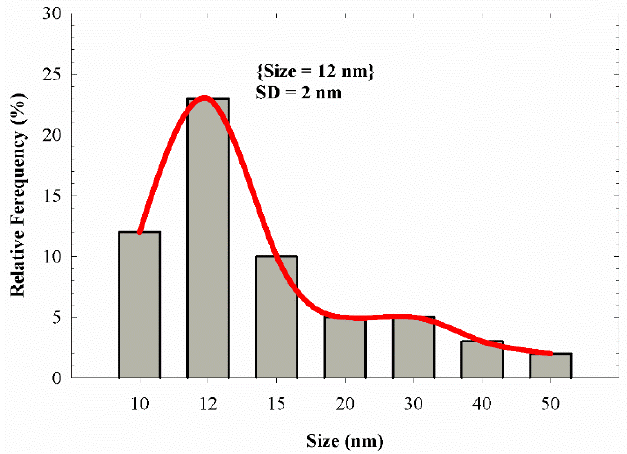
Figure 5. TEM images of Pd/coral reef nanocomposite. ( a ) 120 nm; ( b ) 100 nm.